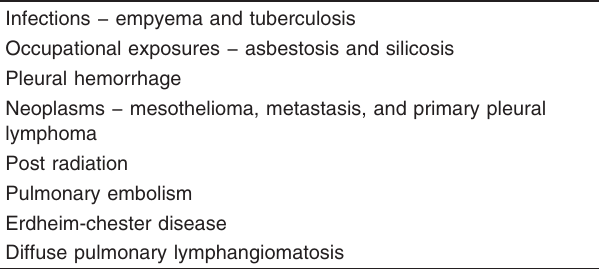
Table 1 Causes of diffuse pleural thickening Infections − empyema and tuberculosis Occupational exposures − asbestosis and silicosis Pleural hemorrhage